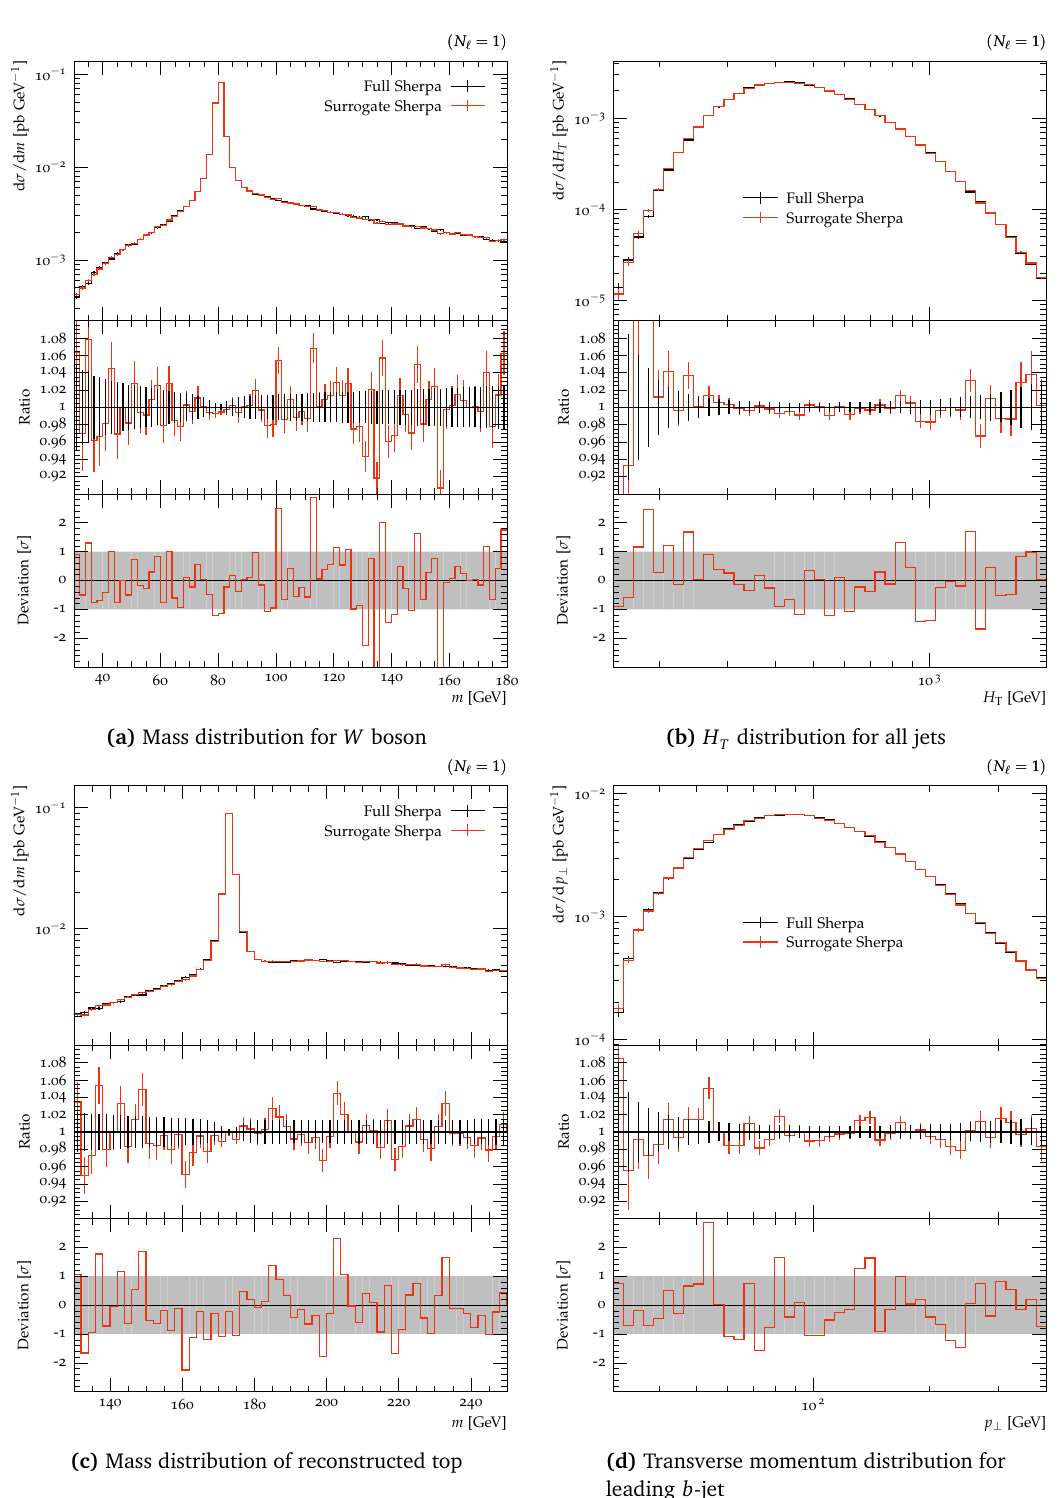
Figure 8: Comparison of different differential distributions generated using S HERPA with (red) and without (black) an NN weight surrogate for the process uu → t ¯ t guu with subsequent leptonic top-quark decays in proton–proton collisions (cid:112) s = at